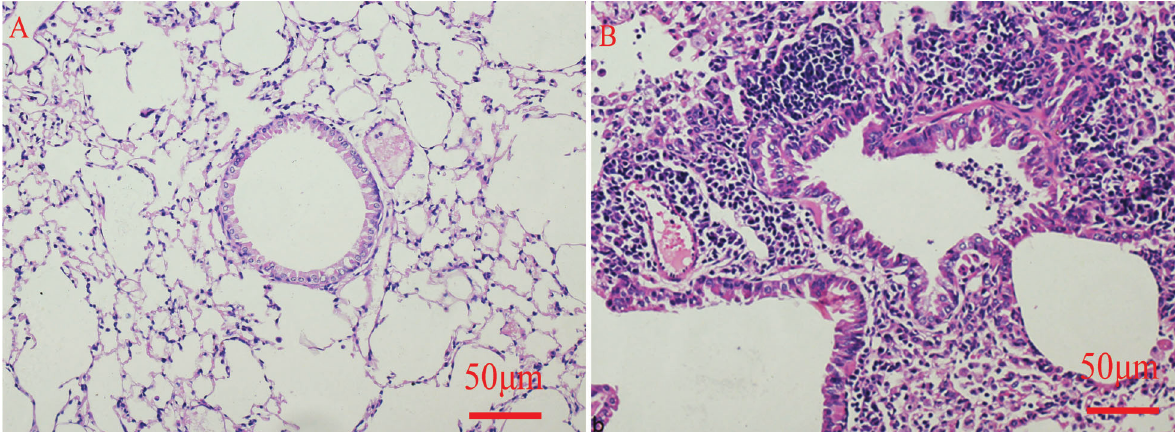
Figure 3. HE staining ( (cid:3) 200; bar, 50 m m) showing the asthmatic group ( B ) with spotty in fi ltration of eosinophils around the airway, bronchioles, and blood vessels, compared to the normal control group ( A